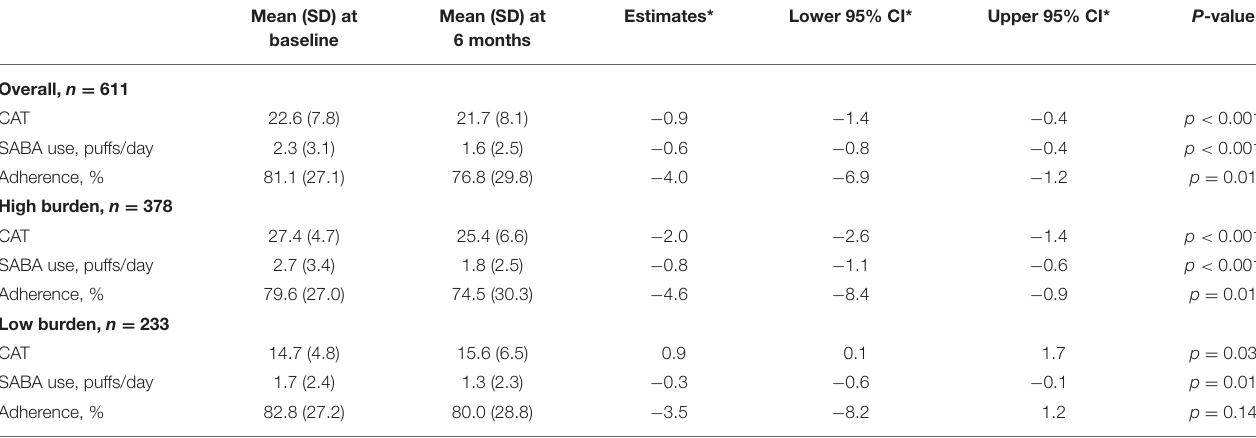
TABLE 2 | Change in CAT, SABA use and adherence over 6 months using linear mixed effects models. Mean (SD) at